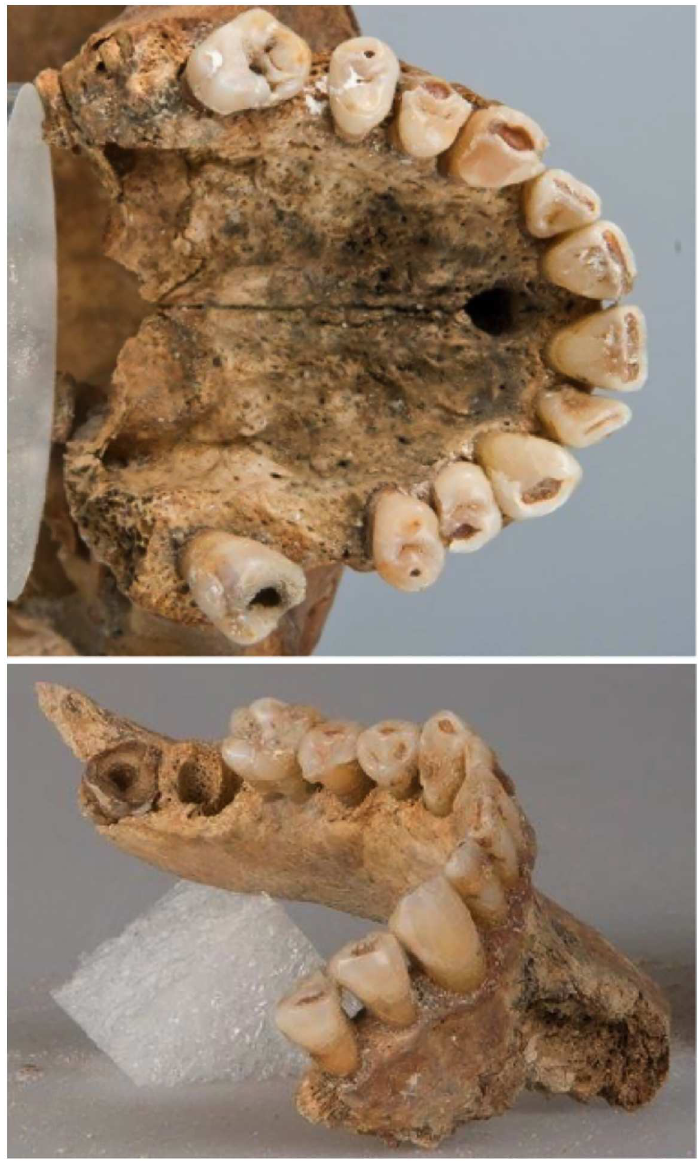
Fig 6. Occlusal view of the maxilla (top) and right oblique view of the mandible (bottom).